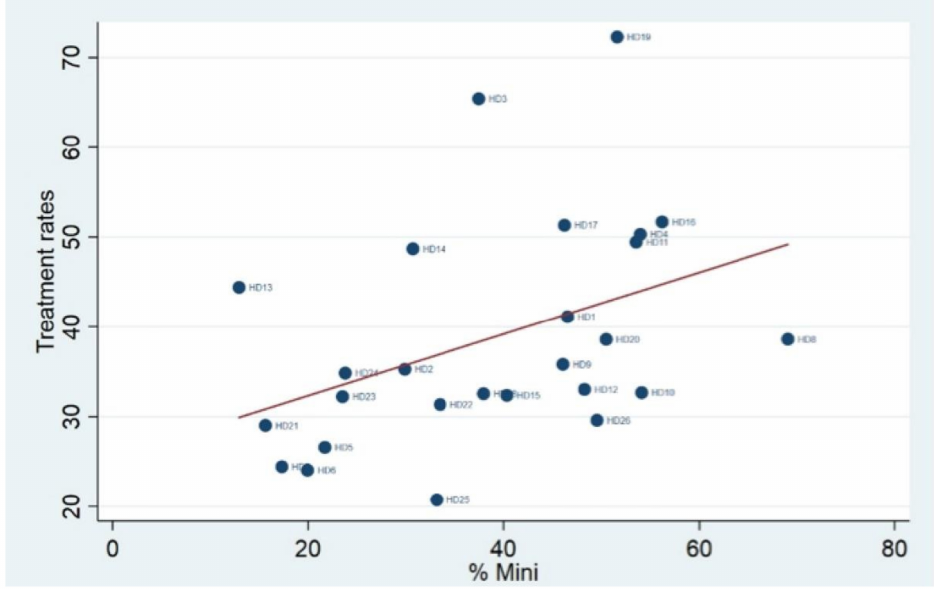
Figure 3. Correlation between treatment rates and percentage of minimally invasive